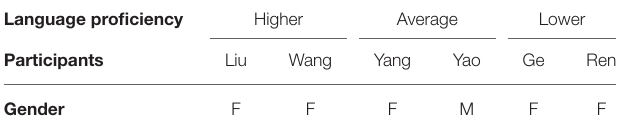
TABLE 1 | Information about the